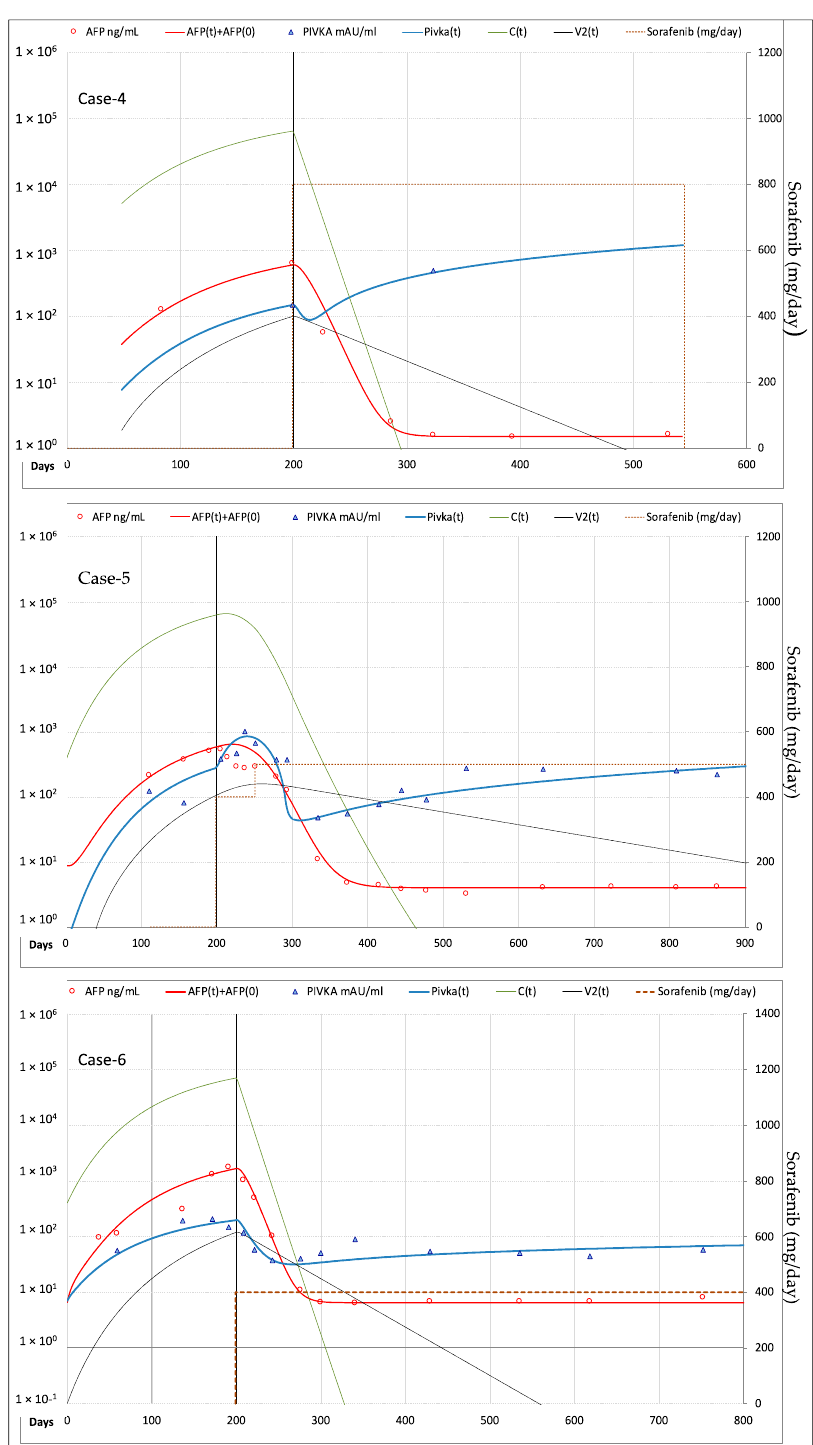
Figure 7. Best fitting of AFP and PIVKA-II serum levels in the 3 patients with CR of the target lesion. In Case-4 the modeling analysis is stopped when sorafenib treatment was discontinued and patient underwent liver transplantation. In Case-5 and Case-6 modeling analysis is stopped when they developed new HCC lesions at different sites after 25.7 and 18.4 months of therapy. Legend : AFP = measured AFP; AFP(t) = model computed AFP; AFP(0) = AFP normal value; PIVKA-II = measured PIVKA-II; Pivka(t) = computed PIVKA-II; C(t) = model computed cancer cells; V2(t) = model computed vascularization